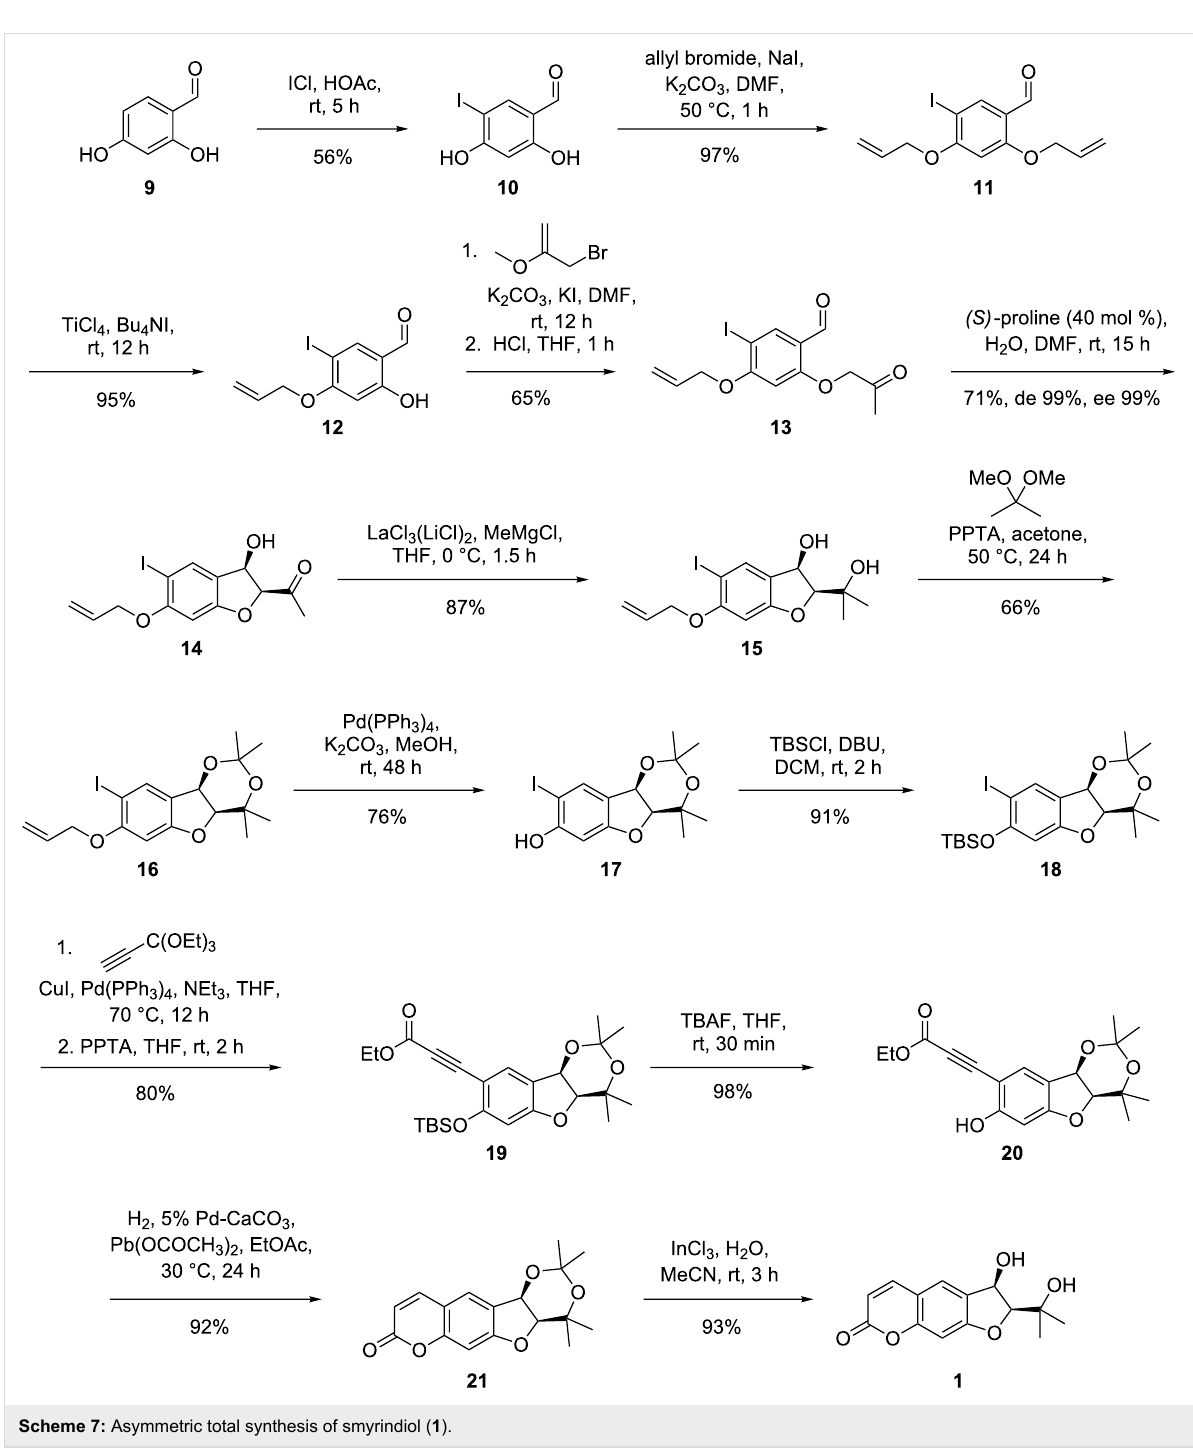
acetonide 15 or were found to be impossible to cleave after- wards while leaving the rest of the molecule